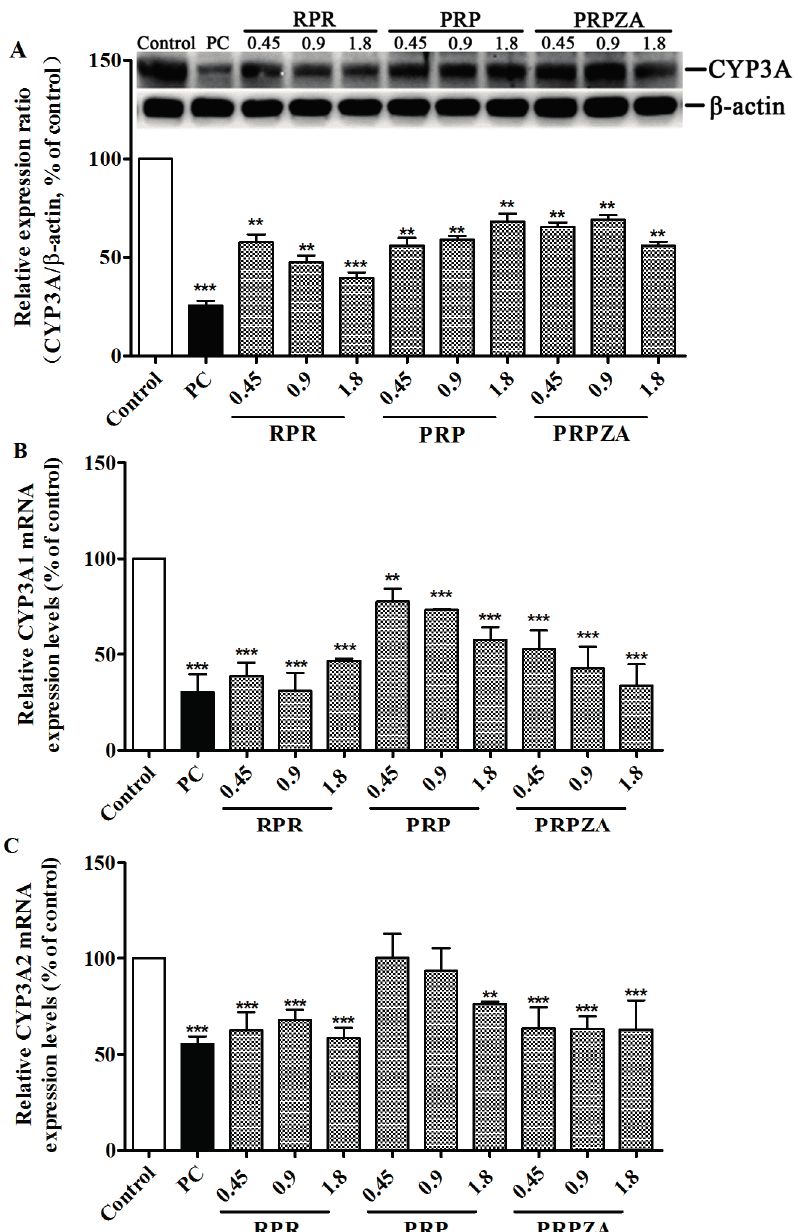
Figure 4. CYP3A protein ( A ); CYP3A1 mRNA ( B ) and CYP3A2 mRNA ( C ) expression levels in rat livers. Before the rat livers were prepared, rats were orally pretreated with RPR (A); PRP (B); PRPZA (C) (g·kg − 1 ·day − 1 ), or saline once daily for 7 days. The rats were orally pretreated with SKF-525A HCl (0.1 g·kg − 1 , 7 days) as the positive control (PC) for CYP3A inhibition. ** p < 0.01 and *** p < 0.001 compared with the control